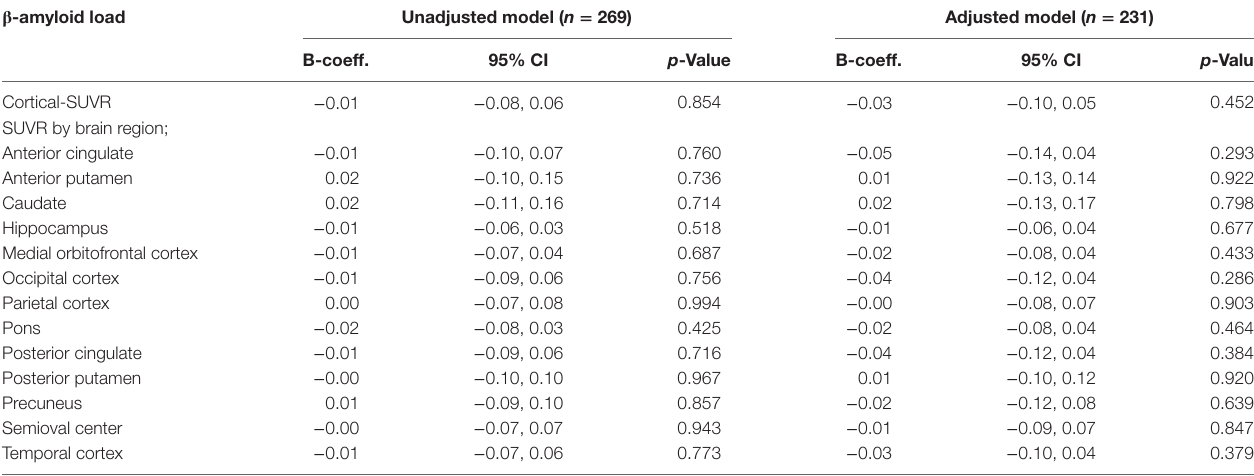
TaBle 4 | Multiple linear regressions examining the cross-sectional associations between chronic fatigue and cerebral β -amyloid